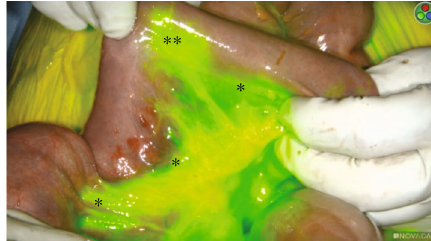
Figure 4: Perfusion to edge of small bowel mesentery but not beyond ( ∗ ) and one focal area of small bowel perfusion ( ∗∗ ).